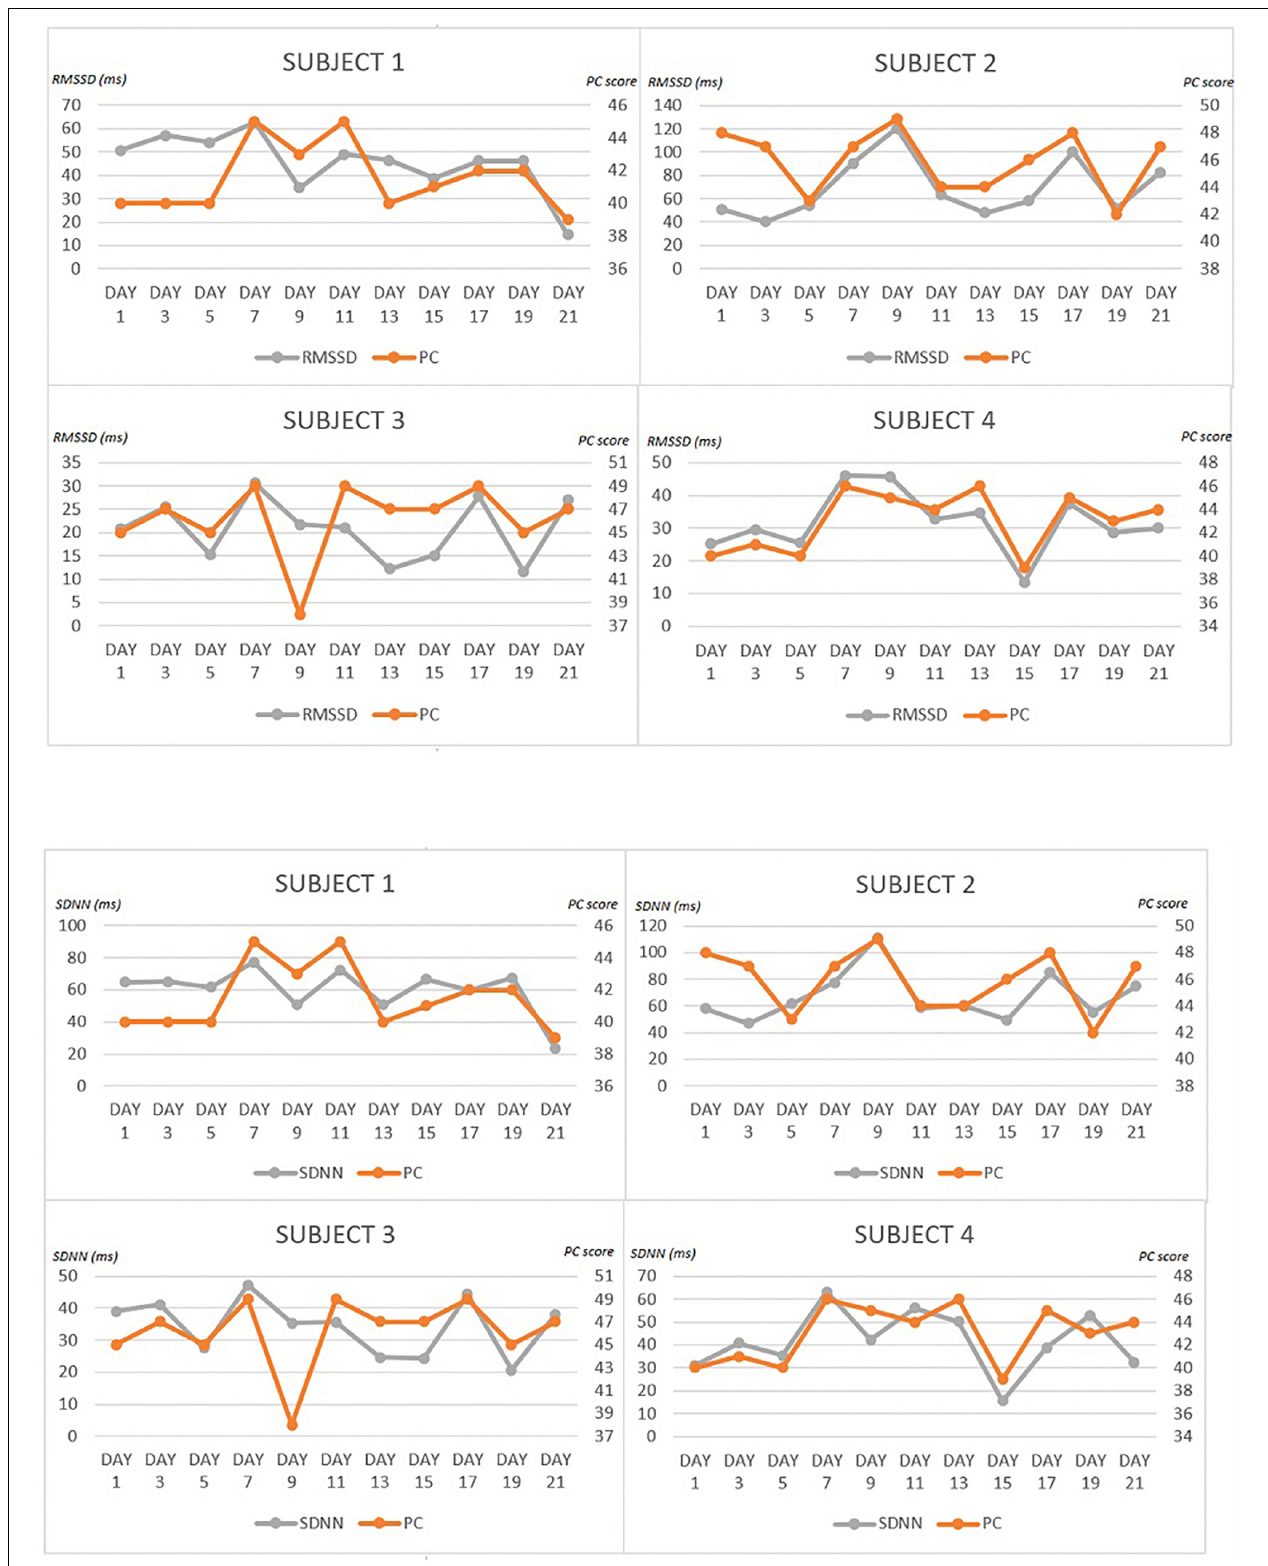
FIGURE 1 | Trend ot the PC values in relation to SDNN and RMSSD for each individual subject.